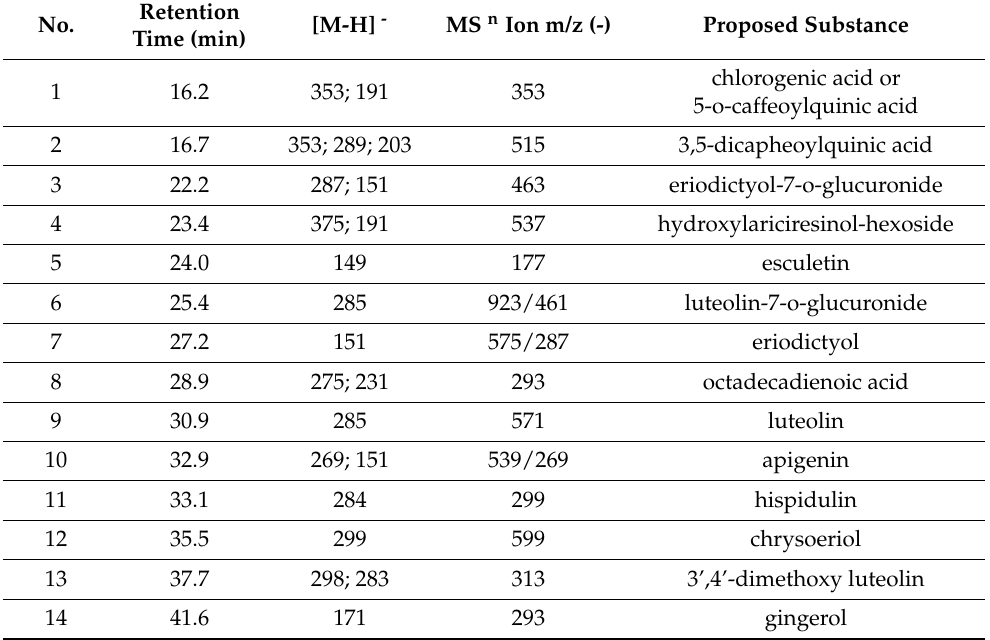
Table 1. Identification of compounds in the hydroalcoholic crude extract of Vernonanthura brasiliana by LC-ESI-IT-MS/MS in negative mode.